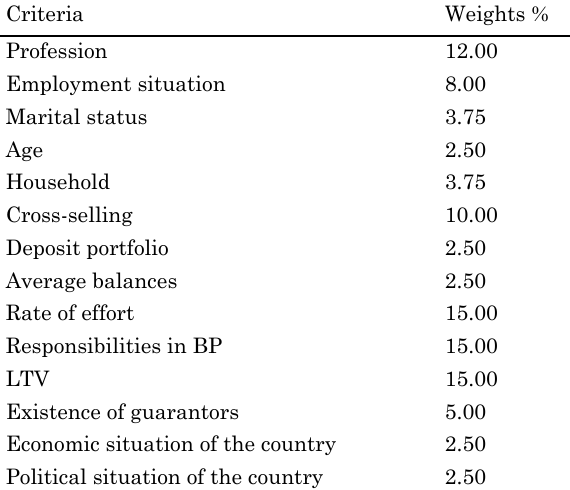
Table 1. Criteria and respective